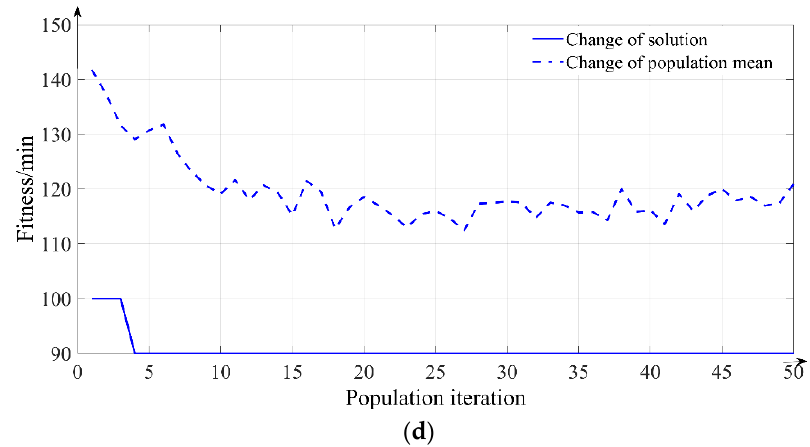
Figure 4. Change of population fitness value. ( a ) 3 aircraft, ( b ) 4 aircraft, ( c ) 5 aircraft, ( d ) 6 aircraft. Table 5. Statistics of support vehicle utilization and completion time of three operations before and after scheduling optimization.